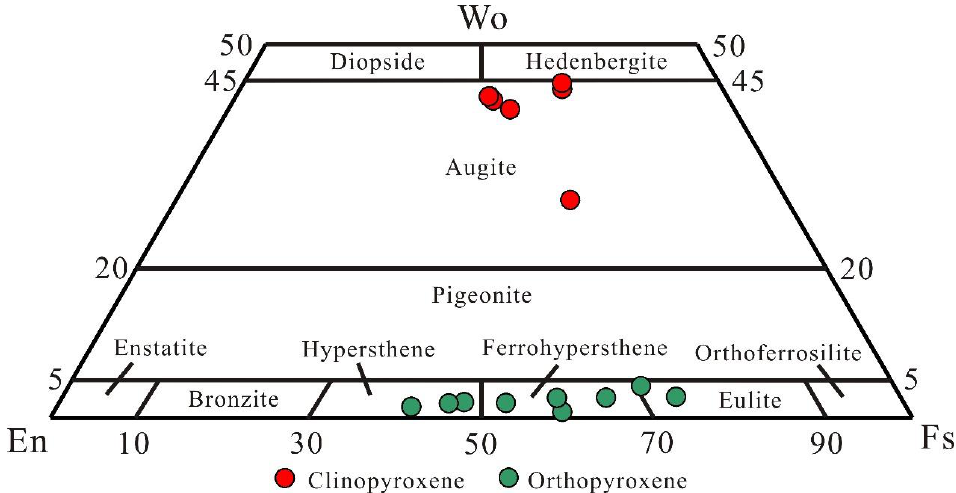
Figure 8. Ternary Calcic pyroxene (Wo)—Enstatite (En)—Orthoferrosilite (Fs) classification diagram of pyroxene (after [62]).